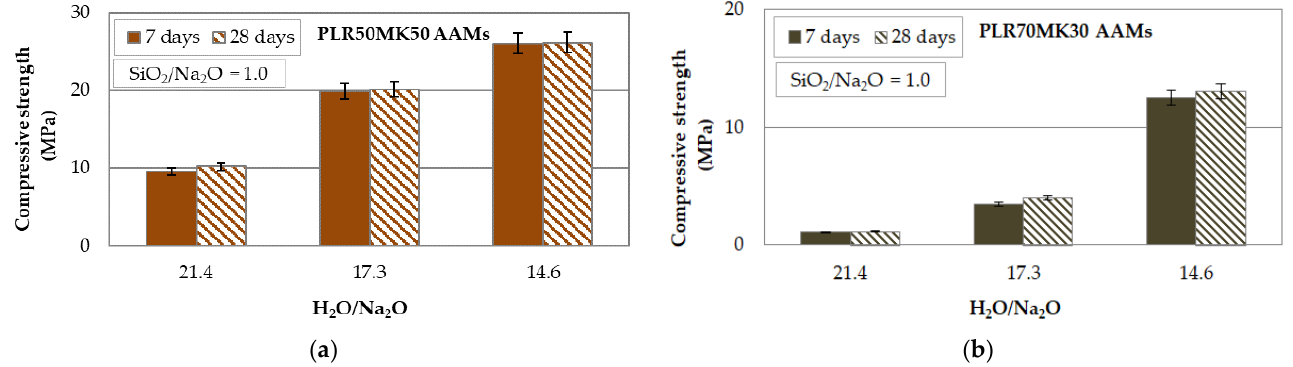
Figure 1. Effect of H 2 O/Na 2 O molar ratio on the activating solution and ageing period on the compressive strengths of ( a ) PLR50MK50 and ( b ) PLR70MK30 AAMs (pre-curing time 4 h, curing temperature 40 °C, curing time 24 h; error bars indicate the standard deviation of measurements obtained from three specimens).